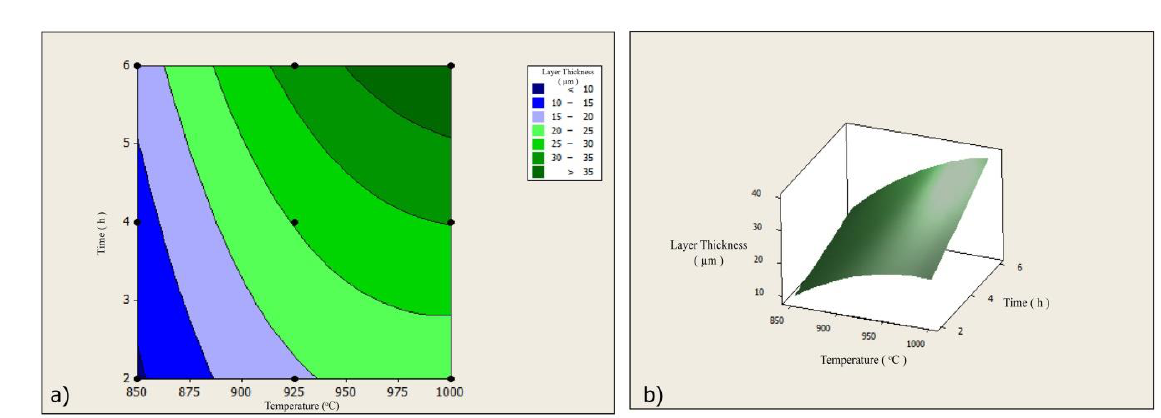
Figure 3. a) Contour plot for borided layer thickness. b) Response surface plot for borided layer